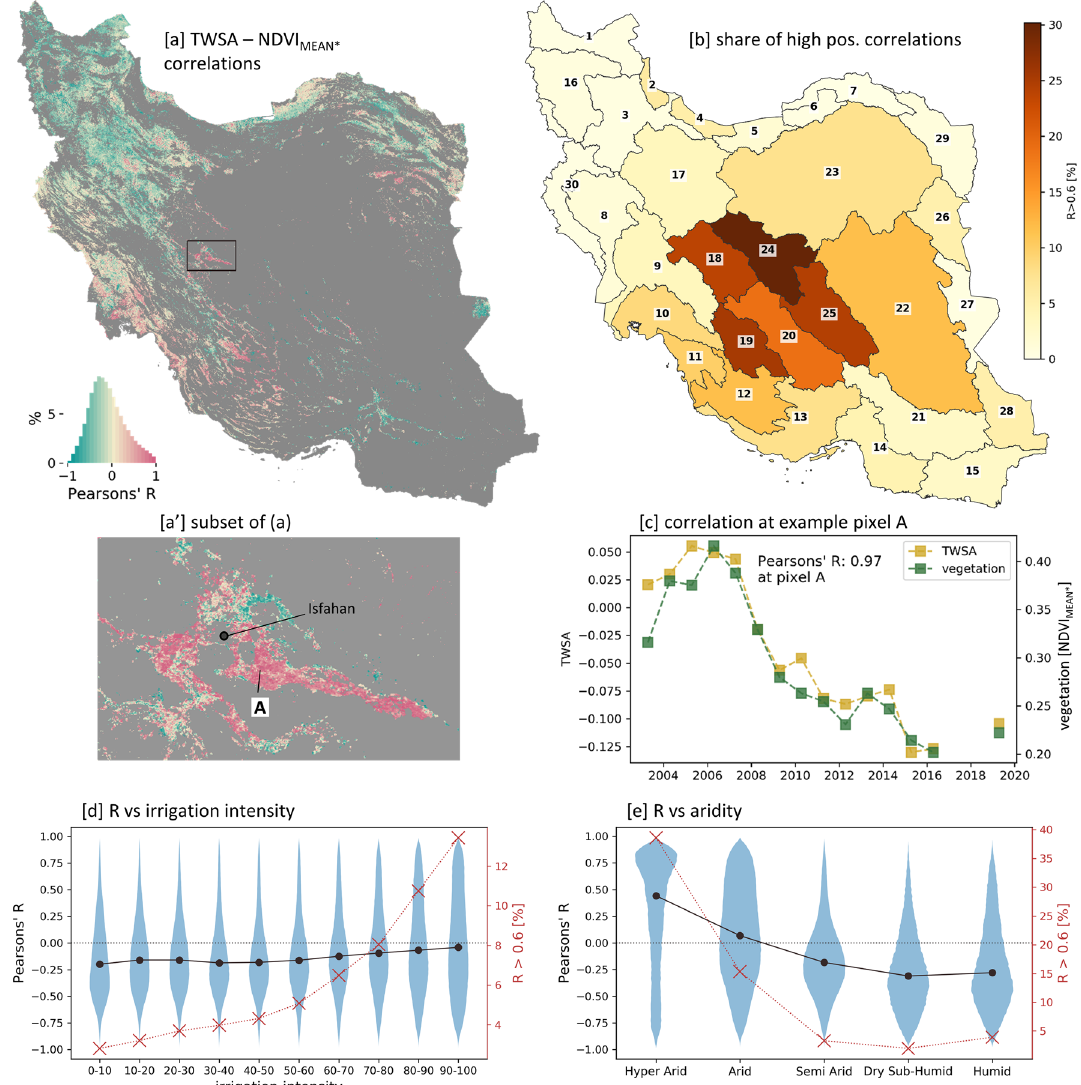
Figure 11. Annual vegetation growth ( NDVI MEAN ∗ ) on agricultural areas compared to annual total water storage anomalies ( TWSA ). ( a ): Map of Pearson correlations between NDVI MEAN ∗ and TWSA . ( b ): Share of highly positive correlated (R>0.6) pixels per basin. ( c ): At an example pixel A, the NDVI MEAN ∗ and TWSA time series and the associated Pearson’s R is plotted. ( d ): R values versus irrigation intensities. e: R values versus aridity. General Notes for d, e: Agricultural areas which were not existing at the start of the analyzed period are excluded (see methods). Irrigation intensity of an agricultural pixel is thereby characterized at the beginning of the period (average irrigation intensity of 2001–2003, see Fig. 9). The analysis versus aridity focuses on rather highly irrigated areas (irrigation intensity > 50). Black dots: median of all data points. red crosses: proportion of negative trends. Maps were created using Python 3.9 (https:// www. python.